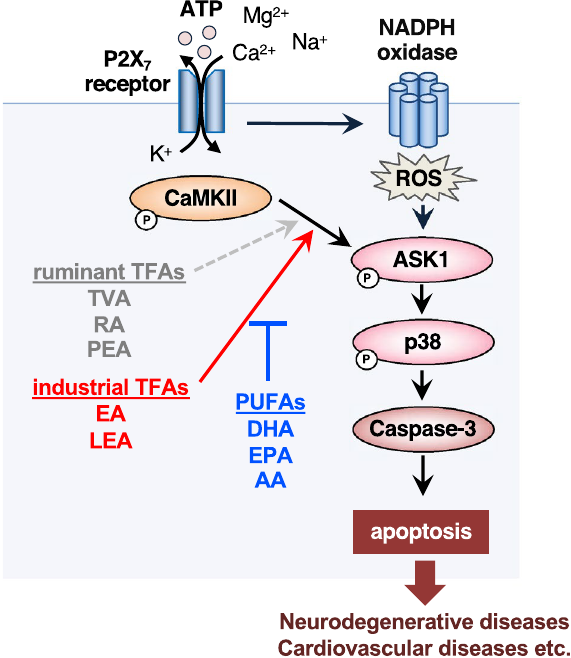
Figure 6. Schematic illustration of the toxic actions of TFAs and the protective actions of PUFAs. Upon eATP stimulation, iTFAs, such as EA and LEA, potently enhanced CaMKII-dependent ASK1 activation and apoptosis (solid red arrow), whereas rTFAs, such as TVA, RA, and PEA, did not (dotted gray arrow). PUFAs, such as DHA, EPA, and AA, strongly blocked pro-apoptotic effect of EA possibly by targeting ASK1, which could be utilized for preventing and combating TFA-related